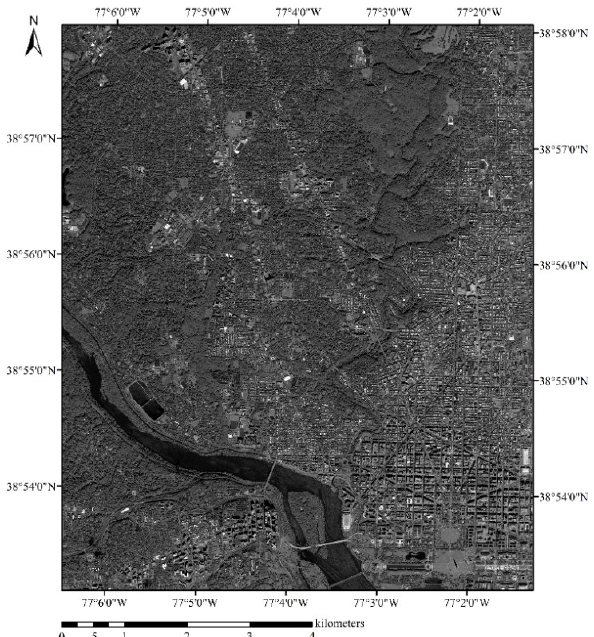
Figure 2. Panchromatic image 1 of the Worldview-1 stereo pair covering the study area.